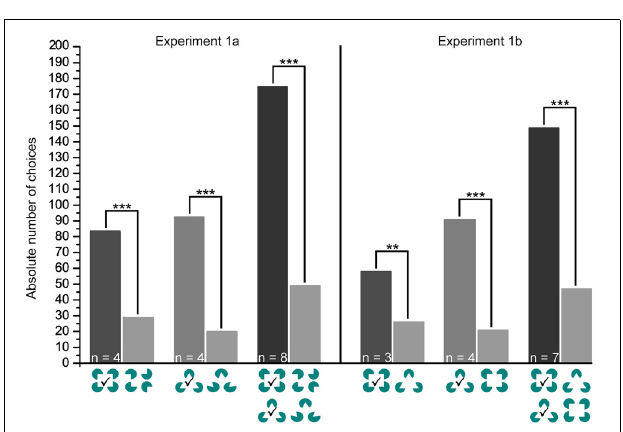
FIGURE 5 | Experiment 1. Shown is the performance of Shark 7 as % of correct choices (symbolized by triangles; left ordinate) per session as well as the average trial time in seconds (symbolized by gray bars; right ordinate) per session per phase until the learning criterion was reached.